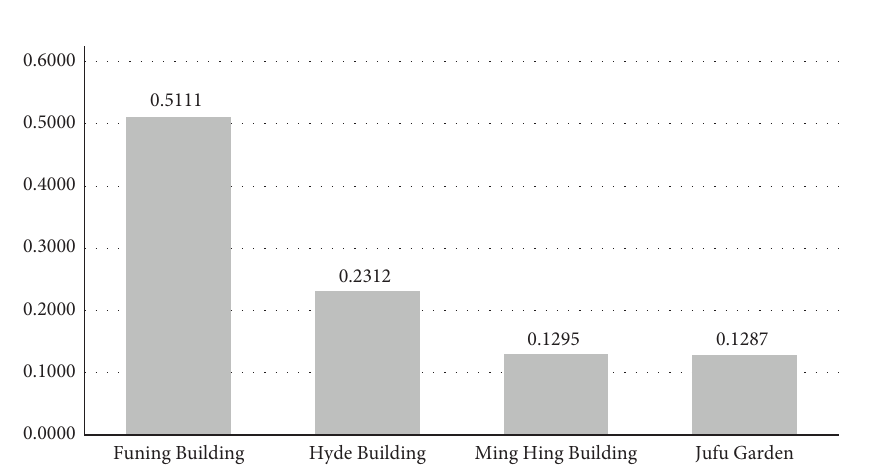
Figure 6: Site selection evaluation of Macau urban renewal projects (source: self-drawn by the